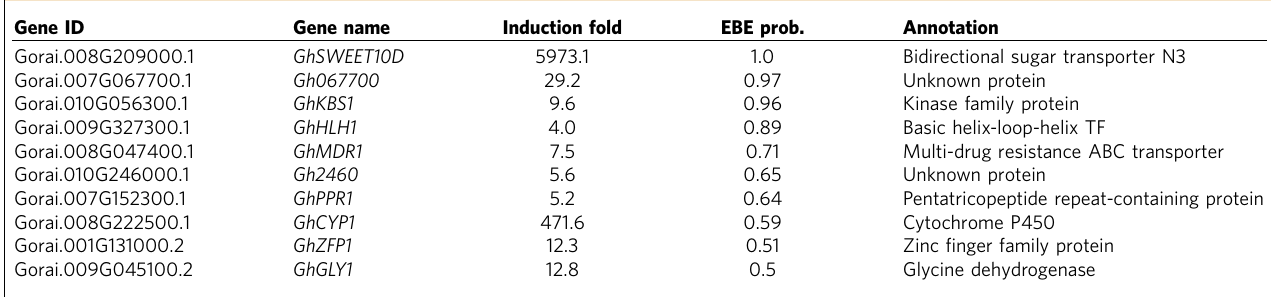
Table 2 | The list of top 10 candidate target genes of Avrb6 in cotton based on their inducibility by Avrb6 and the probability of Avrb6